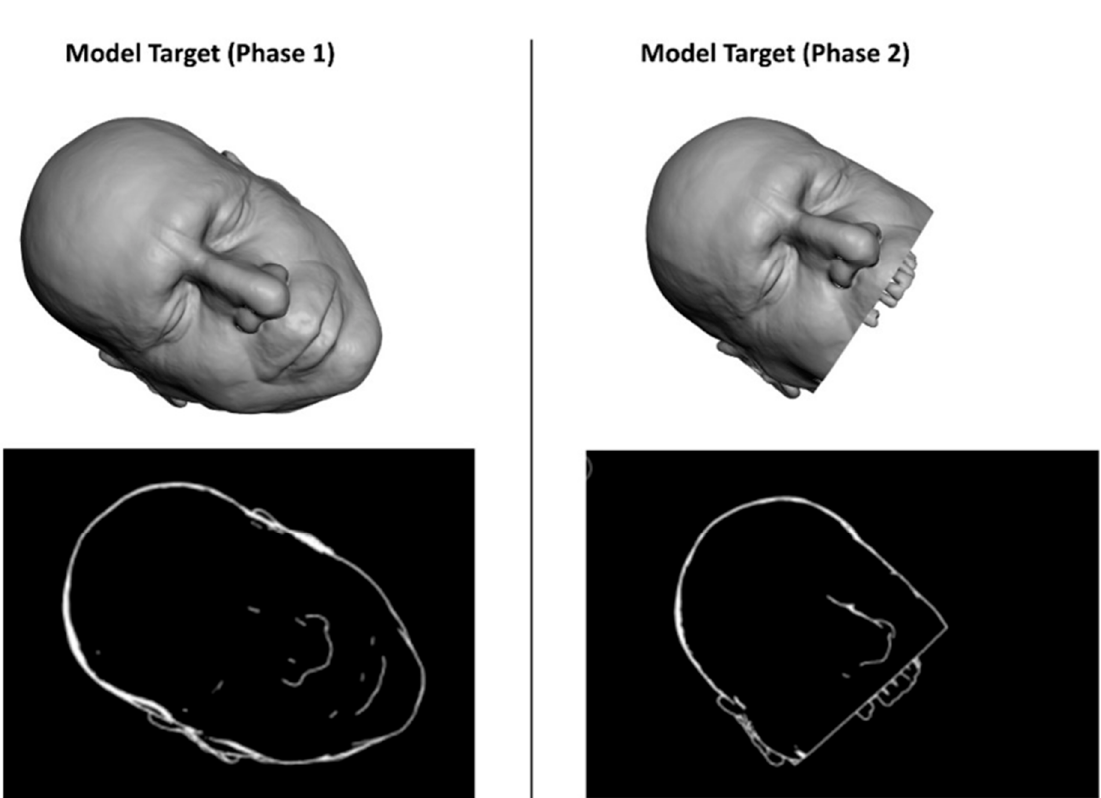
Figure 4. The STL model of the facial skin was used as Model Target for patient tracking.